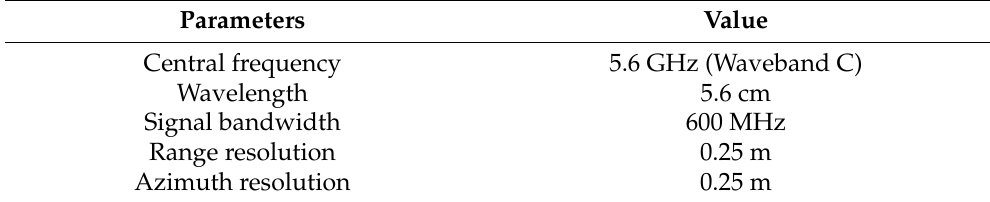
Table 4. GB-SAR system parameters.